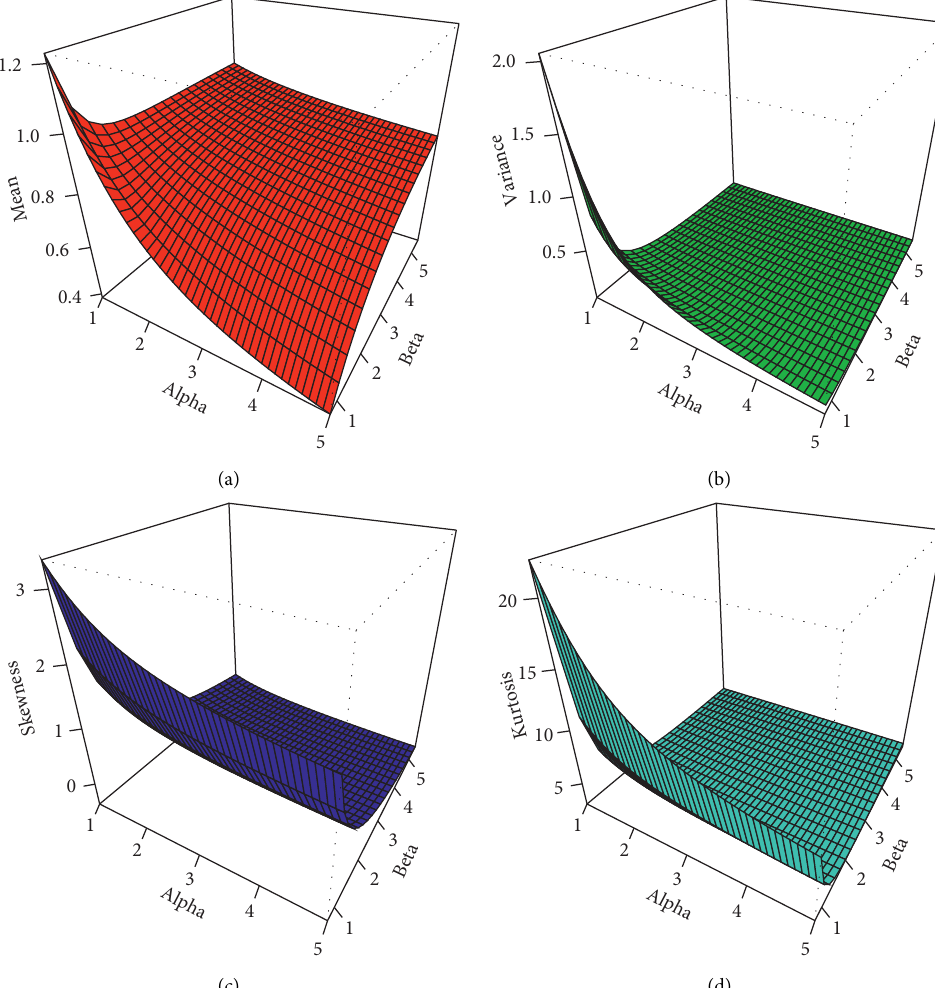
Figure 5: Graphical display of the mean, variance, skewness, and kurtosis of the proposed